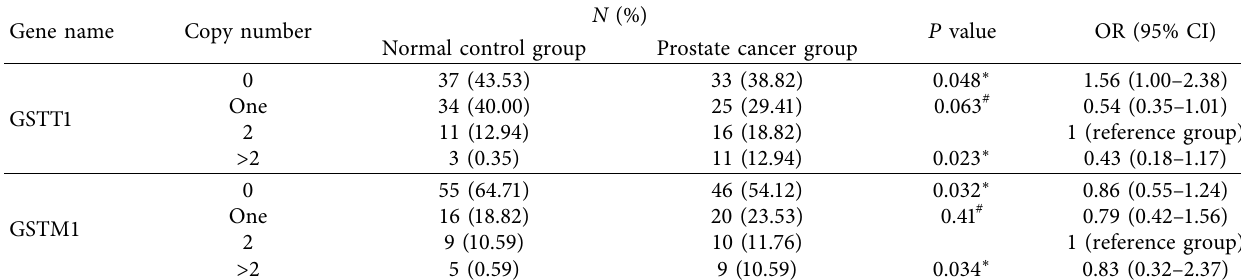
Table 5: Genotype distribution of GST in the subjects of two groups.